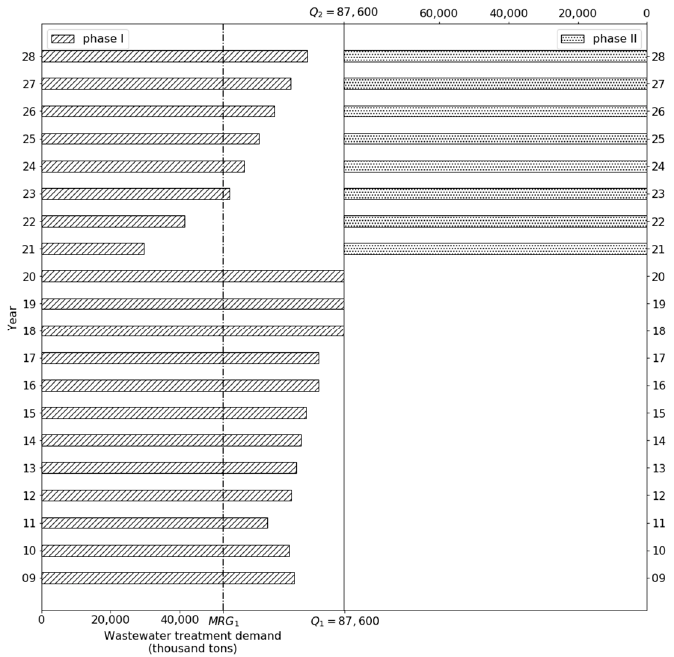
Figure 5. Demand sharing where ER is provided to the phase II project.